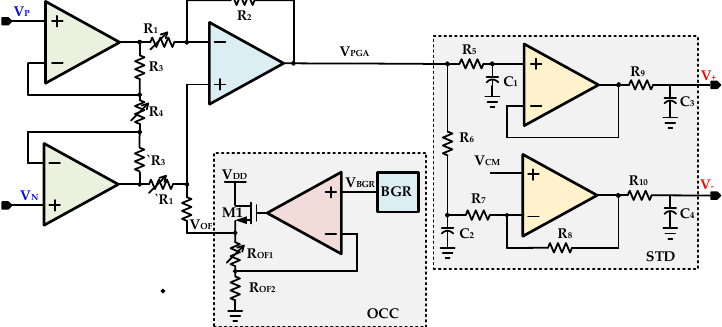
Figure 8. Programmable gain amplifier (PGA) with offset compensation (OCC) and single to